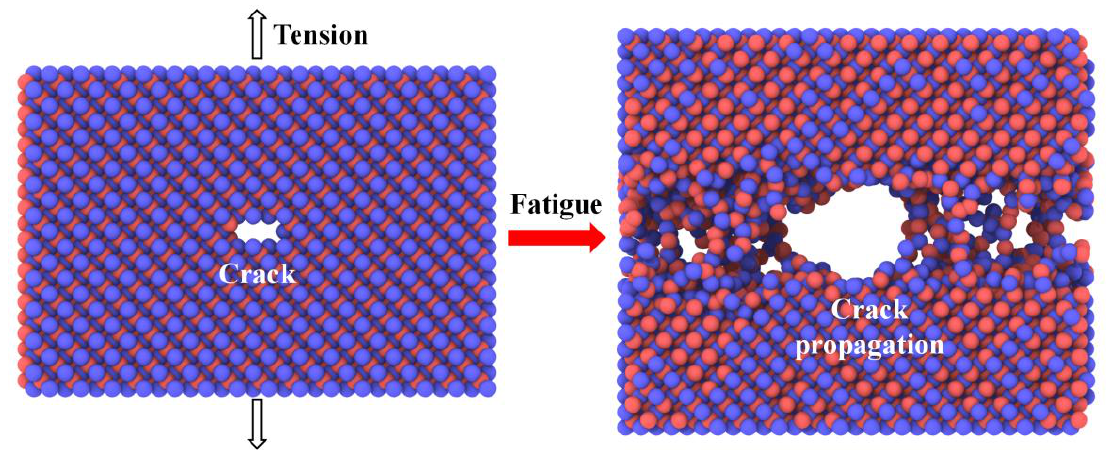
Figure 14. The typical fatigue damage simulation model of SiC [93].